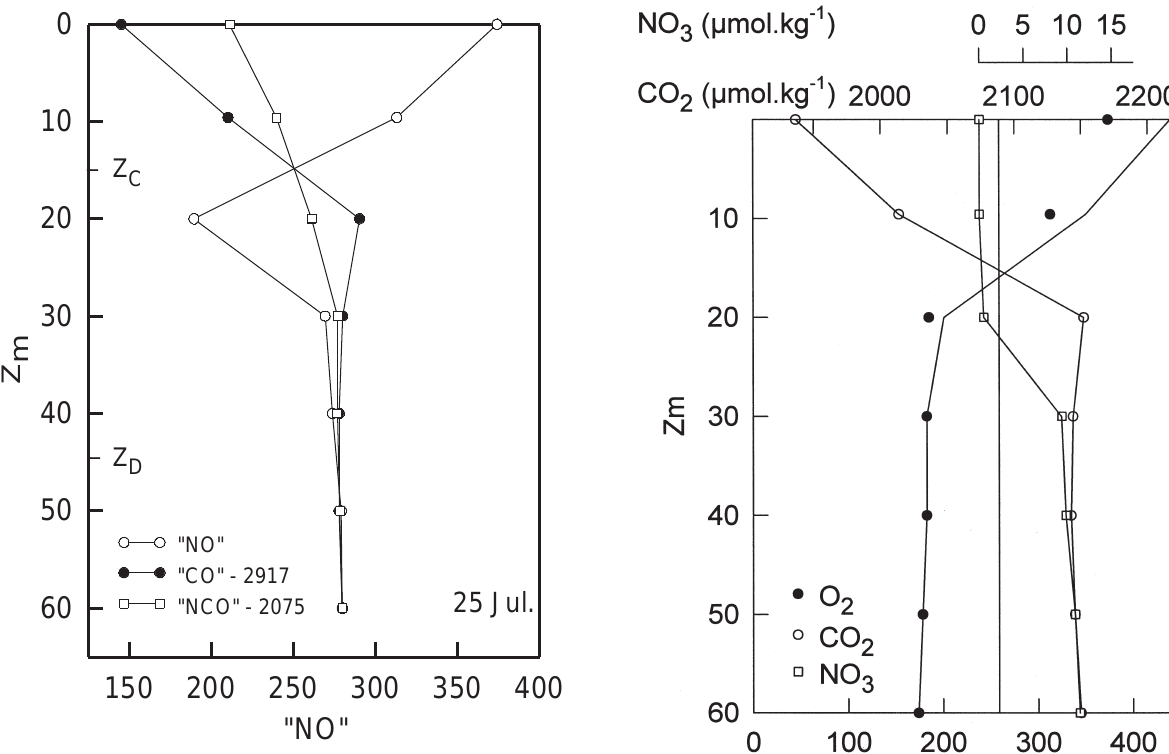
F IG . 4. – The same plot as in Figure 2 eight days later after a relaxation of upwelling (25 July) and occurrence of a red tide bloom.